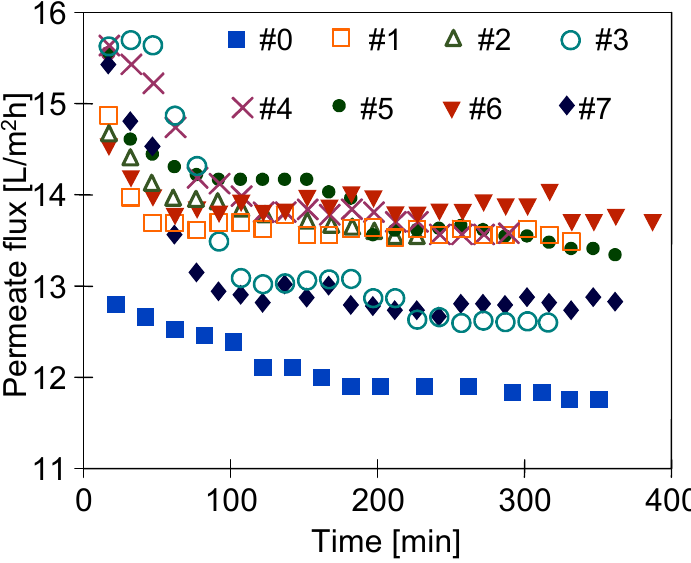
Figure 9. Changes in permeate flux during the MD process with membranes treated by plasma. Feed: NaCl solution (5 g/L). One month after plasma treatment.